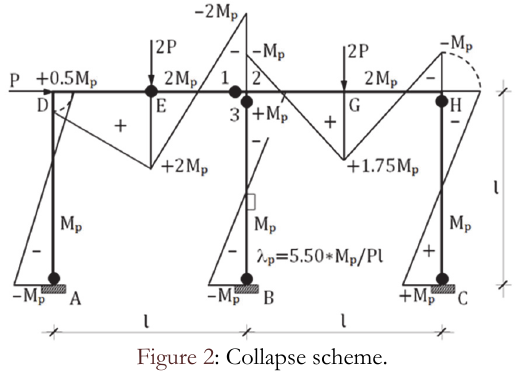
Figure 2: Collapse